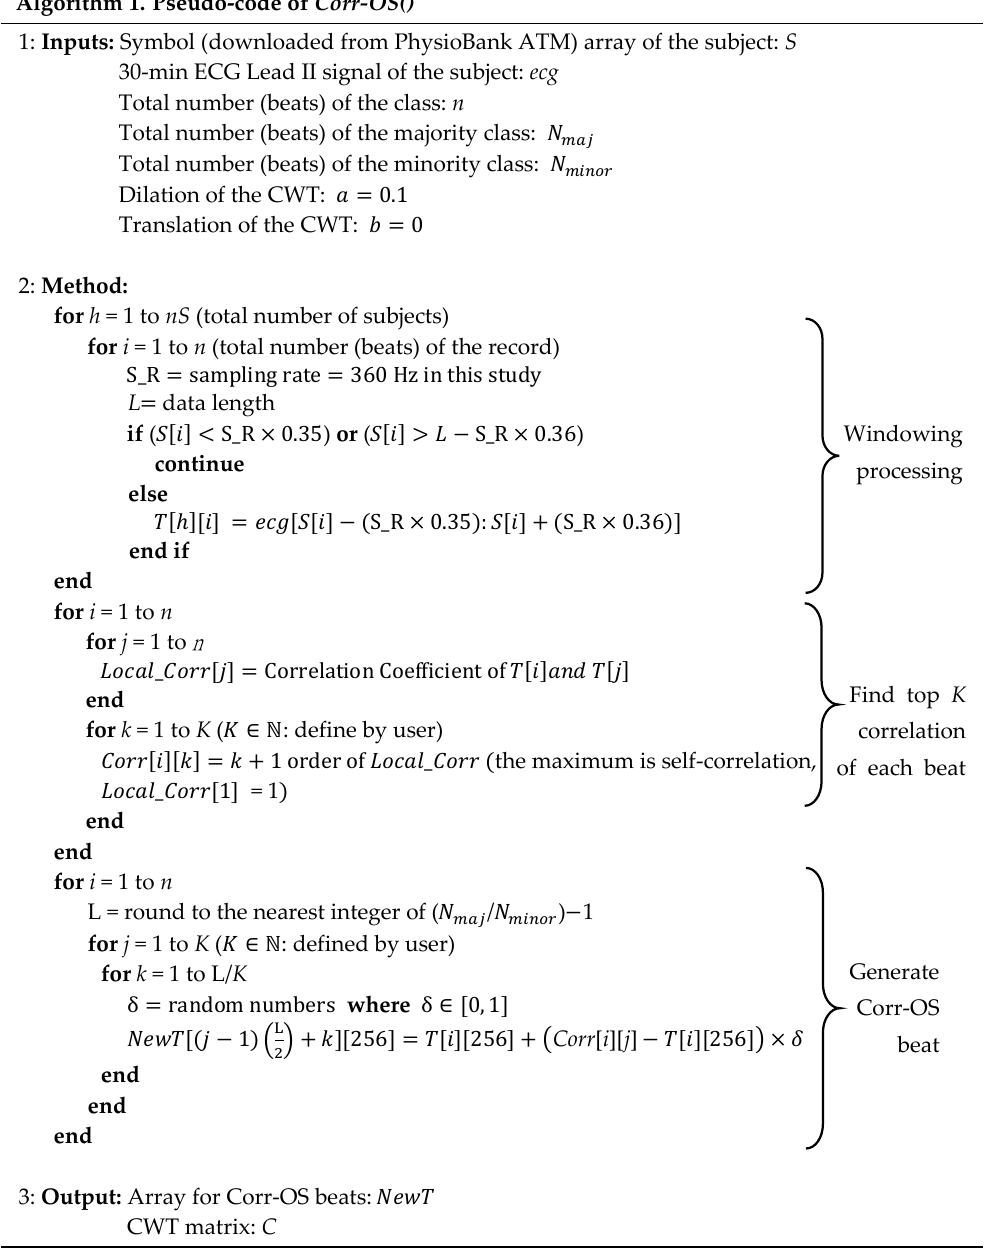
Table 2. Proposed Corr-OS algorithm. Algorithm 1. Pseudo-code of Corr-OS() Algorithm 2. Pseudo-code of